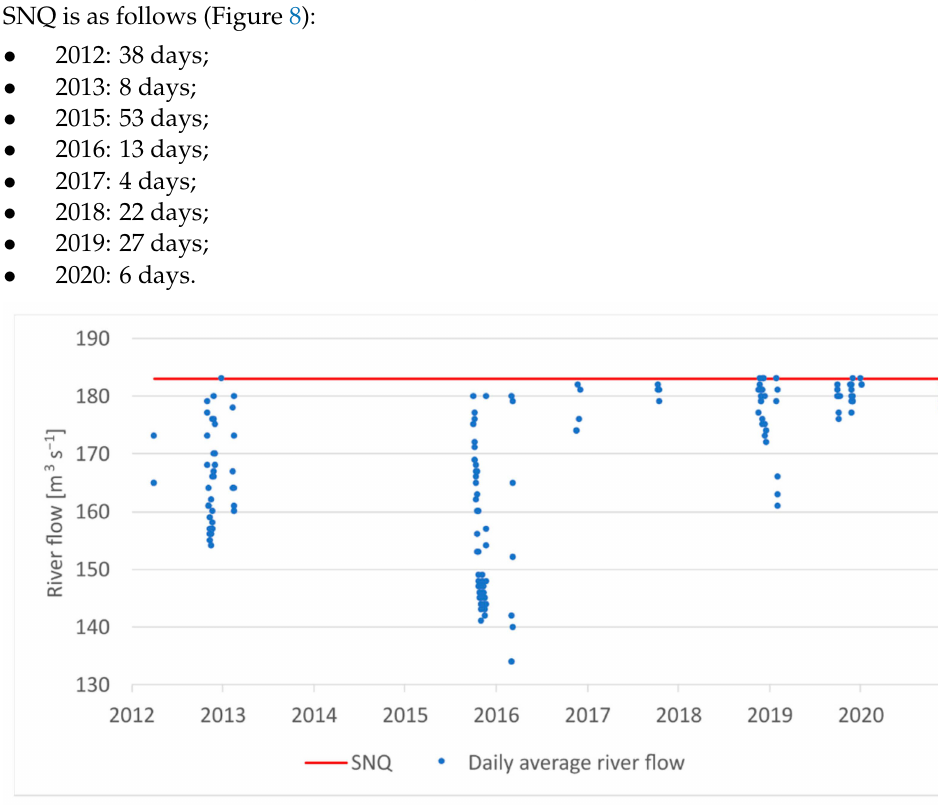
Figure 8. Flow values lower than or equal to the SNQ